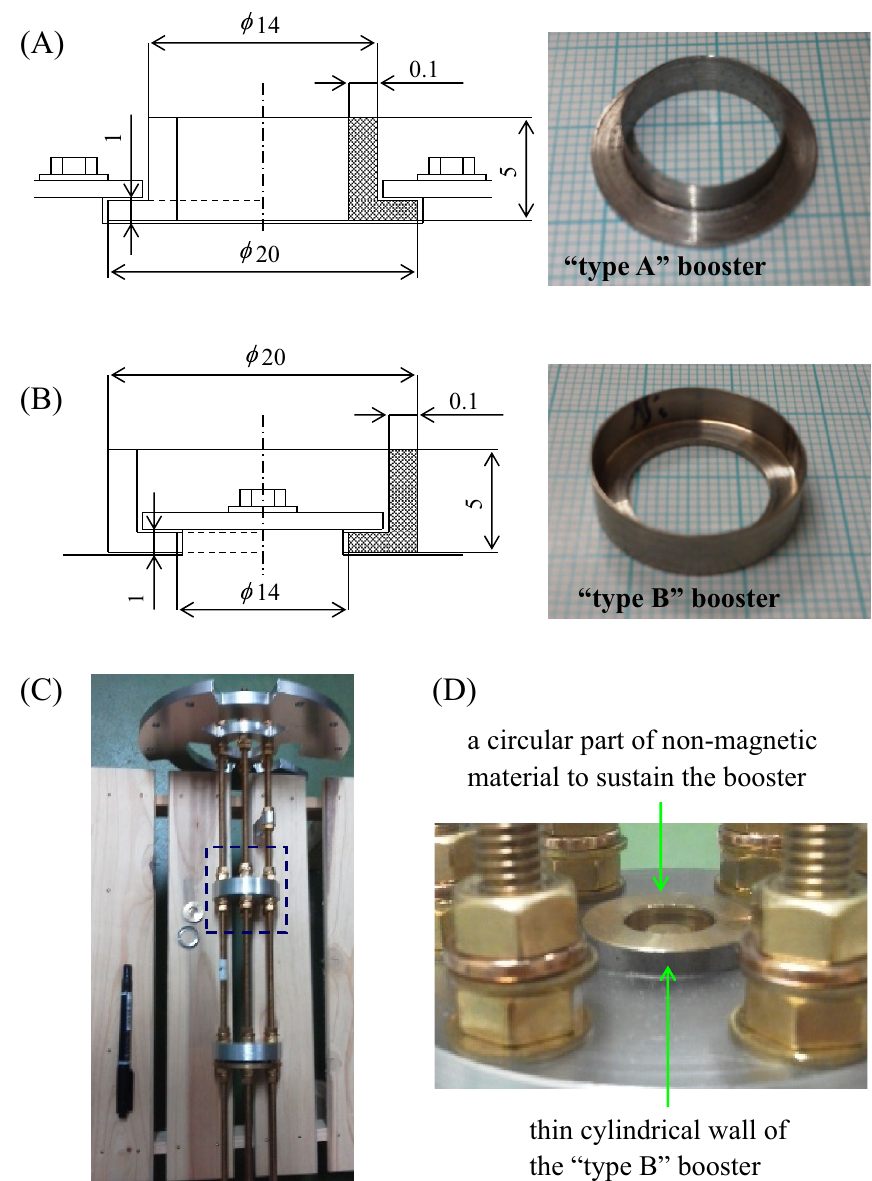
Figure 2. Schematic illustrations and actual photos of newly developed magnetic force boosters (2 types). The magnetic force booster of ( A ) type A, and ( B ) type B. Both boosters are made of stainless steel (ISO X6Cr17 (AISI-430 alloy). The volume of the type A booster is 182 mm 3 , and the type B booster is 185 mm 3 . A thin cylindrical wall (0.1 mm), common to both types, is essentially important to locally strengthen the MF r . ( C ) shows the overall photo including the booster and a nonmagnetic support table. The booster was set on the table where the broken line is presented. ( D ) Close-up photo of the type B booster arranged on the support table. This is fixed by sandwiching the bottom with a circular plate of non-magnetic